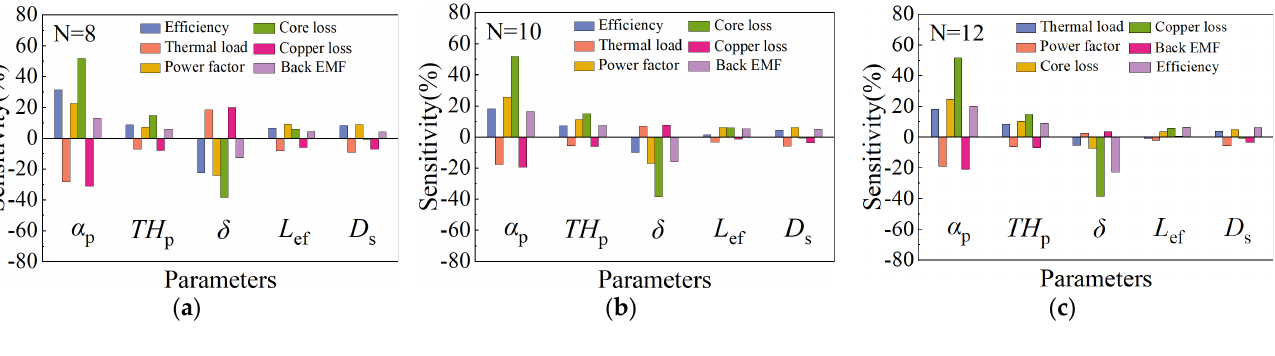
Figure 10. Sensitivity values for optimization parameters. ( a ) Conductors per slot N = 8; ( b ) conduc- tors per slot N = 10; ( c ) conductors per slot N =